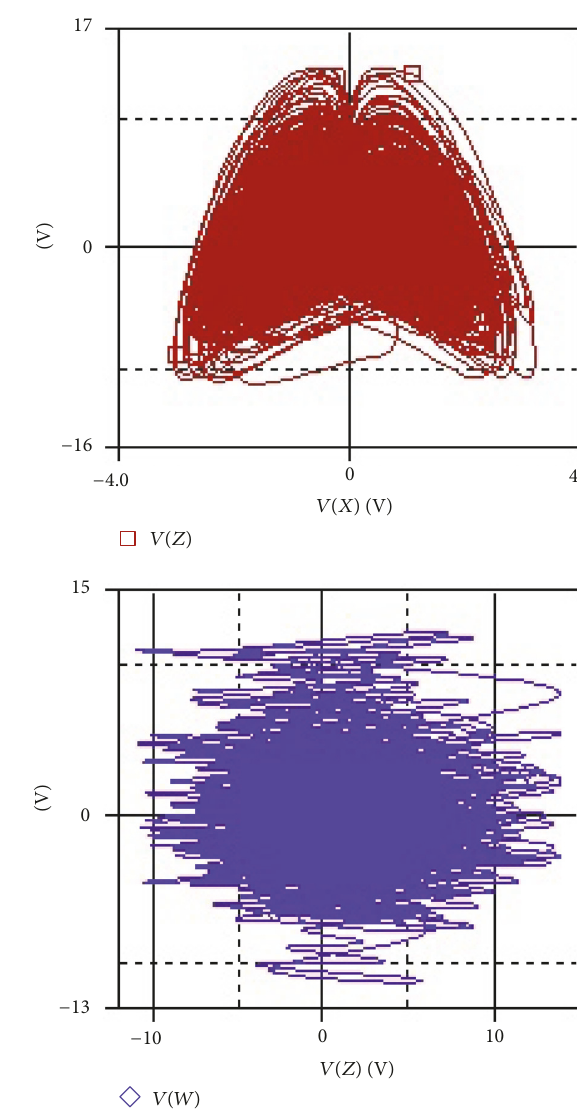
Figure 9: The experimental circuit of the hyperchaotic circuit.